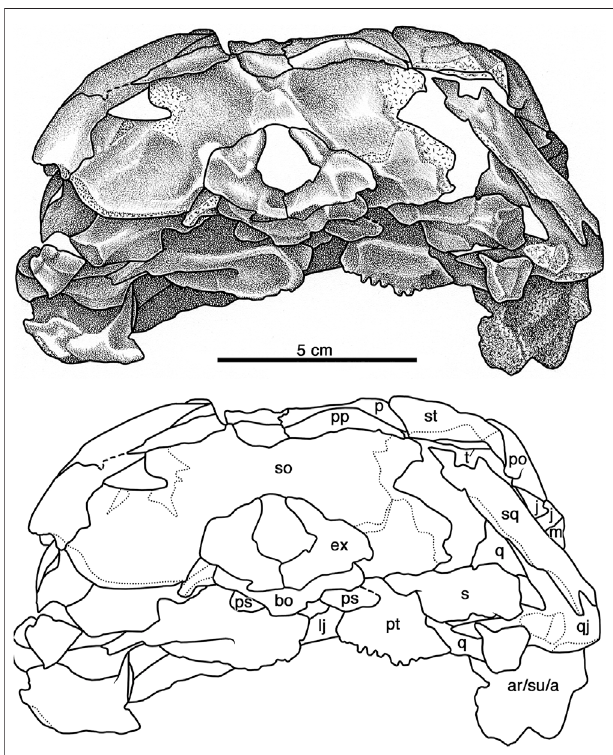
FIGURE 9 | Cotylorhynchus romeri , OMNH 04329, referred specimen. Occipital view of skull. Abbreviations as in Figure 6 .